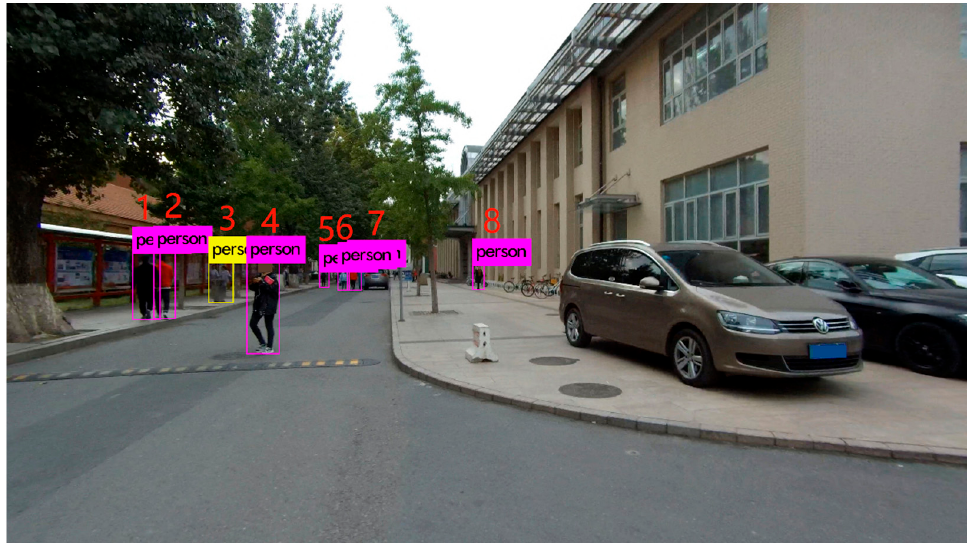
Figure 5. Scene 2 in CUMTB-Campus.